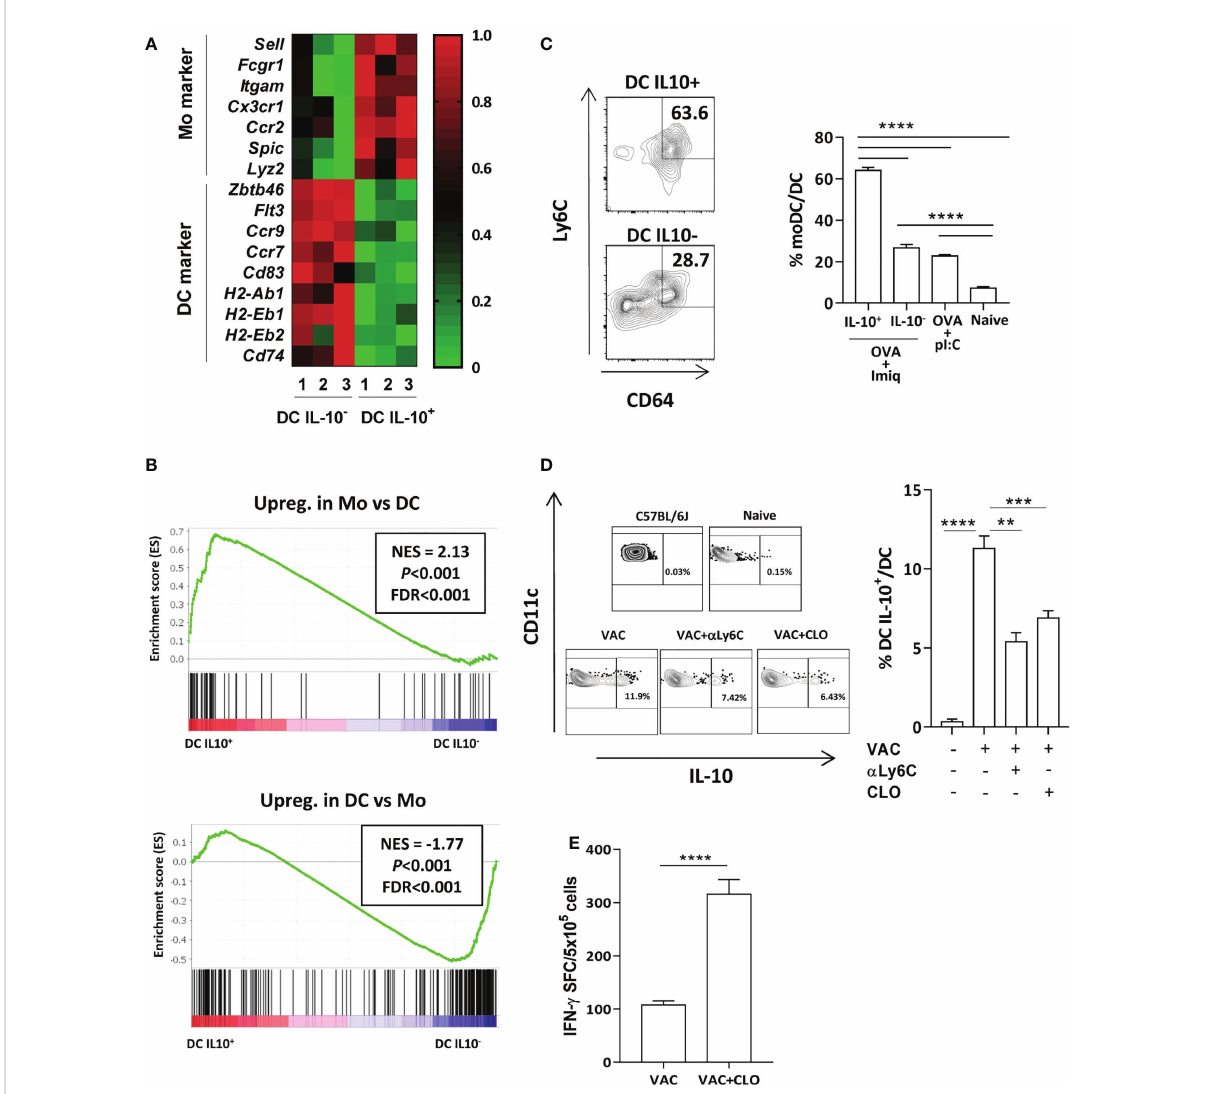
FIGURE 2 Most DC IL-10 + have a monocytic origin. (A) Expression heatmap of monocyte- and DC-associated genes in DC IL-10 + vs DC IL-10 - according to RNAseq data. (B) Gene set enrichment analysis of genes found in DC IL-10 + using gene signatures from the Immgen database observed in monocytes (upper panel) or in DC (lower panel) NES: normalized enrichment score. Statistical parameters (P and FDR) were provided by the GSEA webpage, calculated as described in Subramanian et al. (19). (C) Expression of monocyte markers in splenic DC from vaccinated Vert-X mice according to their IL-10-production capacity. Representative plots (left) and summary (4-8 mice/group). (D) Vert-X mice were immunized with OVA + Imiquimod (VAC) with or without monocyte-depleting agents: clodronate (CLO) or anti-Ly6C antibodies ( a Ly6C). DC were gated as CD11c high , I-A b high cells and the percentage of DC IL-10 + was calculated for each group. A control untreated C57BL/6J mice is also shown. Representative plots (left panels) and summary (n=4 mice/group). (E) C57BL/6J mice (n=6-8/group) were immunized with OVA + Imiquimod with or without clodronate and one week later responses against OVA(257-264) CD8 T-cell epitope were determined by ELISPOT, measuring the number of spot forming cells (SFC). Bars show mean + SEM (**, P < 0.01; ***, P < 0.001; ****, P <